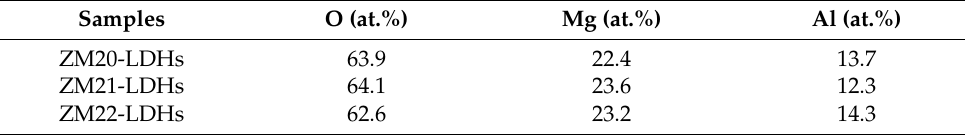
Table 2. The atomic percentage of the layered double hydroxides (LDHs) film on Mg alloys. Samples O (at.%) Mg (at.%) Al (at.%)